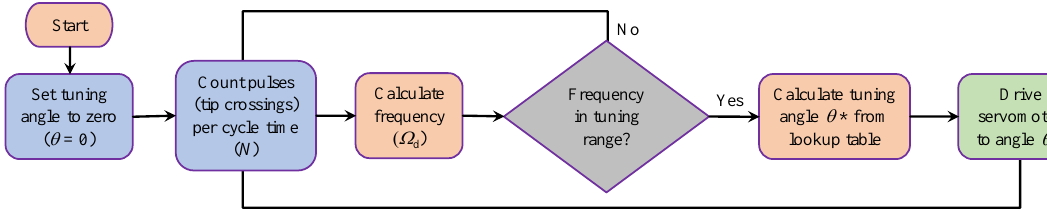
Figure 7. Flowchart illustrating the tuning algorithm.